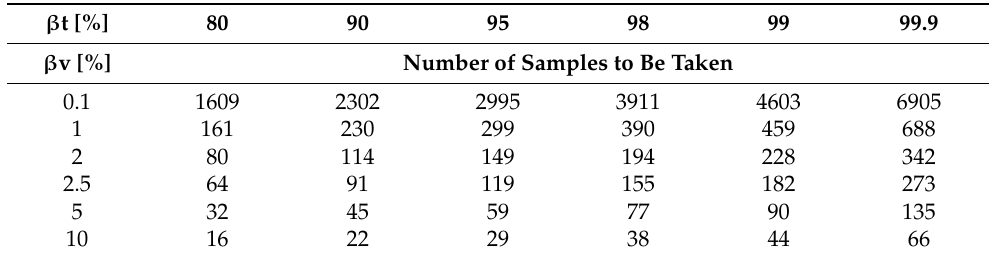
Table 2. Minimum number of samples required to detect at least one residue above a specified con- centration (e.g., MRL) at the selected violation rates (β v ) with pre-defined probability ( β t ).